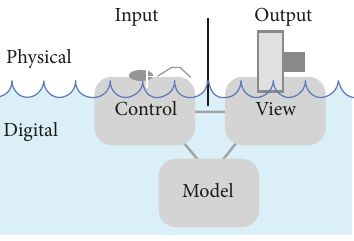
Figure 1: Interaction model of GUI: Model-view-control model from Smalltalk-80